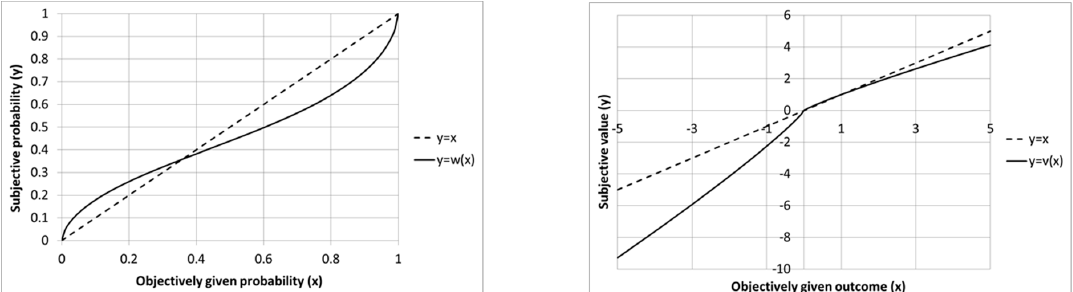
Figure 1. Left panel: The weighted function (solid curve) defined by Equation (9) with parameter γ = 0.65. The horizontal axis represents objectively given probabilities x and the vertical axis is subjective probability denoted by y . The linear function with γ = 1 corresponding to the linear expected utility theory is also displayed (dashed line). Right panel : The value function (solid curve) given by Equation (11) with parameters α = 0.88, λ = 2.25. The x -axis represents objectively given outcomes and the y-axis subjective values. The linear function with α = λ = 1 is also shown (dashed line).